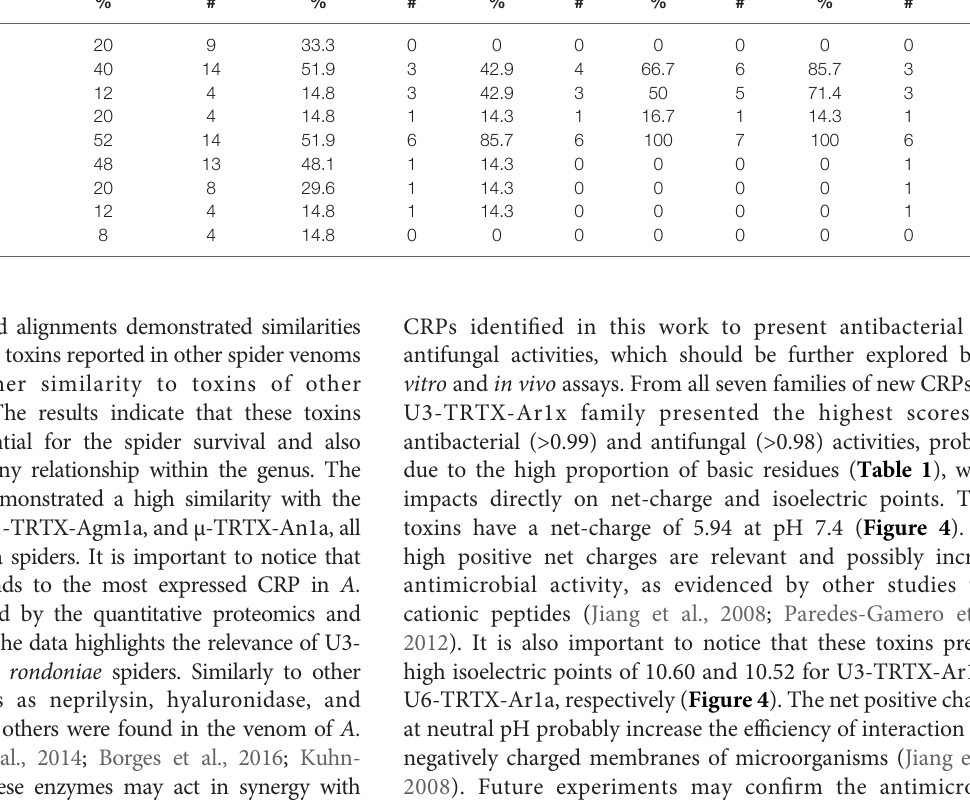
TABLE 4 | Amino acids composition analysis of anticancer peptides (ACPs) predicted by MLACP (Manavalan et al., 2017). Amino acids class Peptide